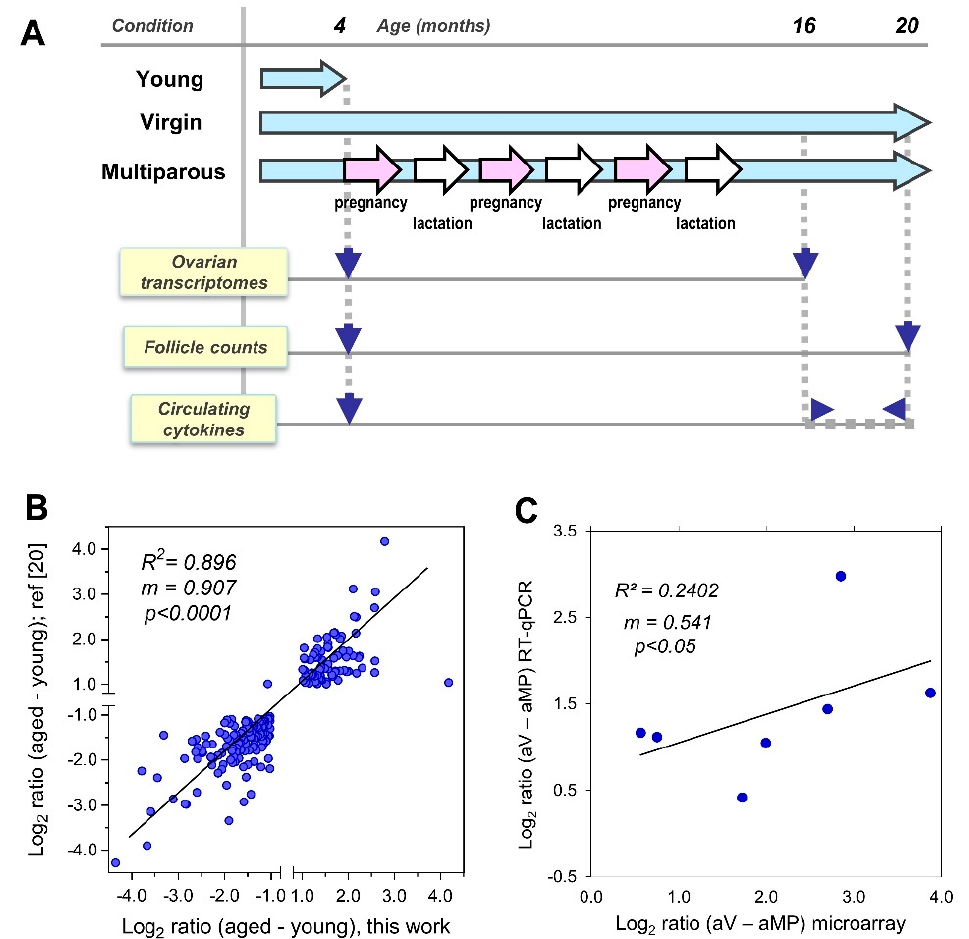
Figure 1. Study flowchart and platform validations: ( A ) Female C57BL / 6 mice were housed from 3 to 20 months in virgin (nulliparous) and multiparous conditions ( n = 70 per group). A group of young adult, four-month-old virgin mice ( n = 20) was used as a reference. Transcriptomic profiling was done in young ( n = 6), 17-month-old virgin ( n = 5) and 17-month-old multiparous mice ( n = 6). The follicle count was performed in young ( n = 3), 20-month-old virgin ( n = 16) and 20-month-old multiparous mice ( n = 18). Serum cytokines were measured at the diestrous stage in adult young, four-month-old mice ( n = 6) and in randomly chosen, 16–20 month-old female mice of both virgin and multiparous groups ( n = 4 per group / month). The time scale shown is not proportional. ( B ) Scatter plot for a 225 genes subset comparing our expression profiling data in young ( n = 6) versus aged ovaries, irrespective of parity ( n = 11), with that obtained with the NIA-22k platform ( n = 2 per group) [20]. Data points between − 1.0 and 1.0 log 2 range were omitted. ( C ) Scatter plot depicting RT-qPCR and microarray results for Foxo1 , Fst, Fshr, Alas2 , Snca , Hba-a1, and Hbb-bt transcripts in the log 2 scale for both platforms, so as to compare the transcription of aged-virgin versus aged multiparous ovaries; n = 3 per group in RT-pPCR assays, n = 5 aged virgin, and n = 6 aged multiparous in microarray data. The squared correlation, slope, and p -values are shown within the